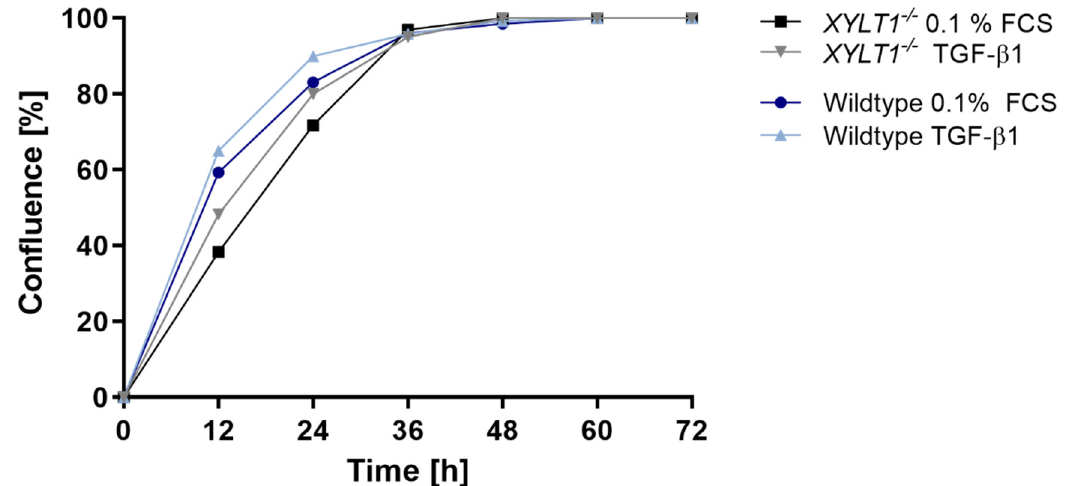
Figure 6. Wound-healing assay. To conduct a wound-healing assay, 1 × 10 6 control and XYLT1 − / − fibroblasts were respectively seeded in a cell culture dish and cultivated overnight. Thereafter, an artificial gap was created within the fibroblast-monolayer and a serum withdrawal from 10% to 0.1% FCS was performed for 24 h. Cells were subsequently incubated with a vehicle (negative control) or TGF- β 1 (5 ng/mL) and wound-healing capability was analyzed for a total of 72 h using a live cell analyzer.